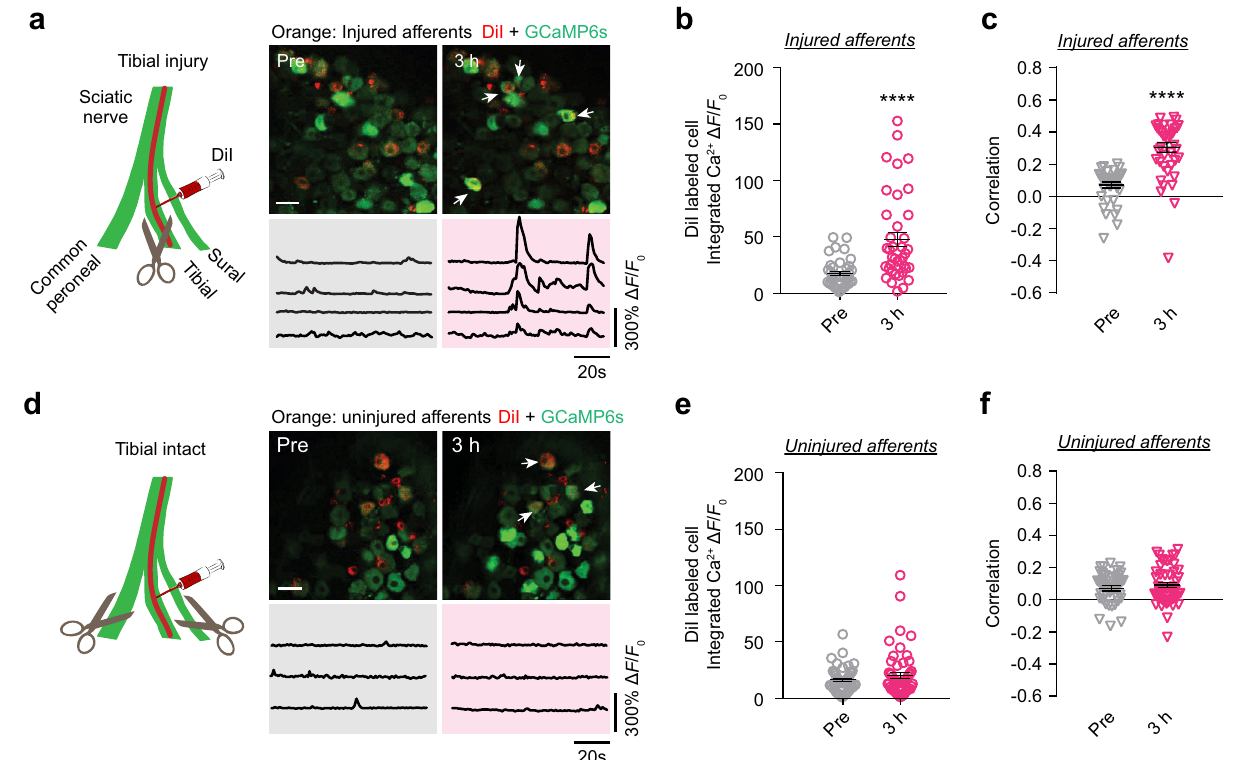
Fig.3|AxotomizedneuronsareinitiatorsinDRGsynchrony.a Schematicshows that retrograde nerve tracer DiI was injected into the tibial branch of the sciatic nerve, and tibial nerve was cut and ligated 7 days after injection. Upper right: representative images of double labeled tibial nerve-injured-neurons and GCaMP6 neurons before and 3hours after tibial nerve cut. Scale, 50 μ m. Lower right: fl uorescence traces of double labeled tibial nerve-injured-neurons shown in upper right panels. b , c The integrated Ca 2+ activity b and correlation coef fi cient c of double-labeled neurons before and 3hours after tibial nerve injury. d Schematic shows thatDiI wasinjected into the tibial branchof the sciatic nerve and the other